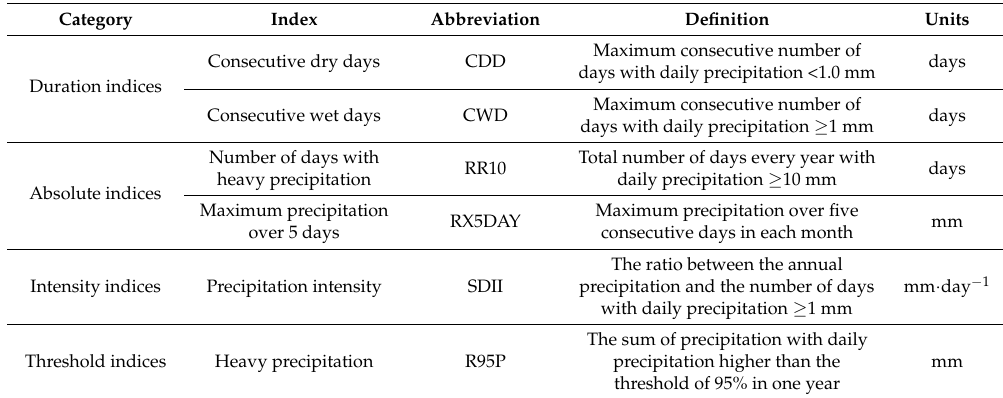
Table 3. Definition of the six extreme precipitation